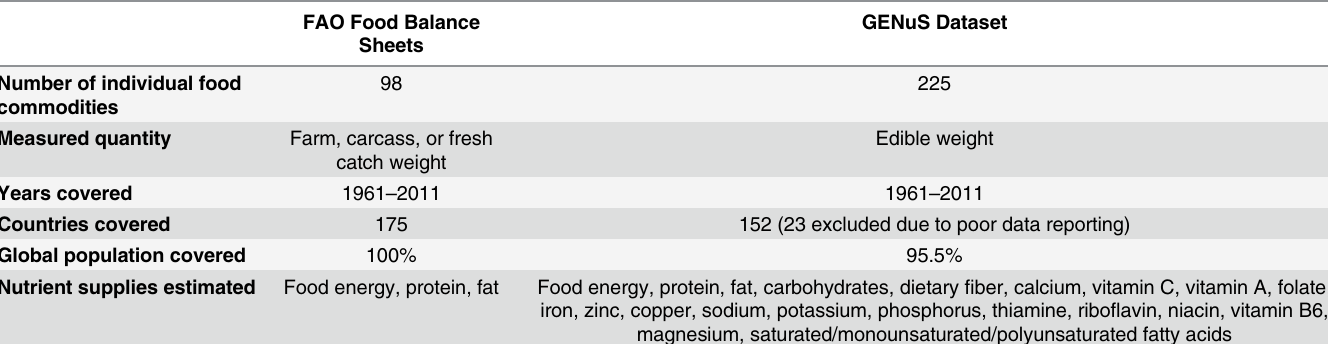
Table 2. FAO Food Balance Sheet – GENuS Dataset